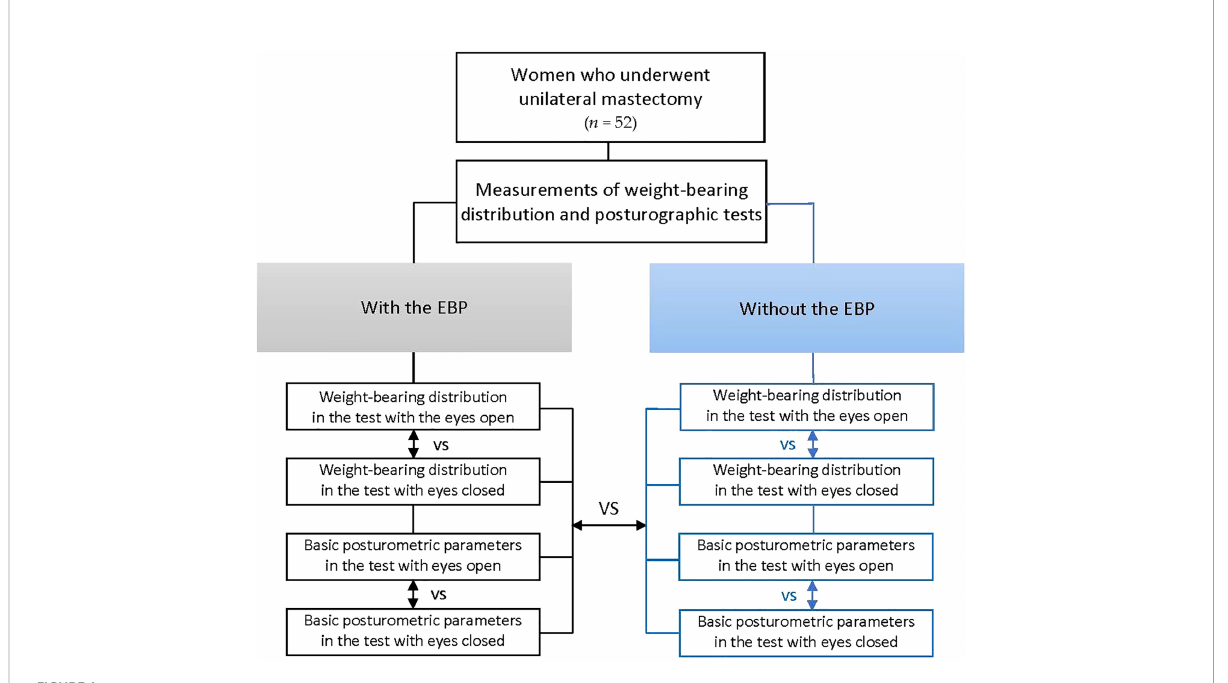
FIGURE 1 Flowchart describing the study fl ow. EBP, external breast